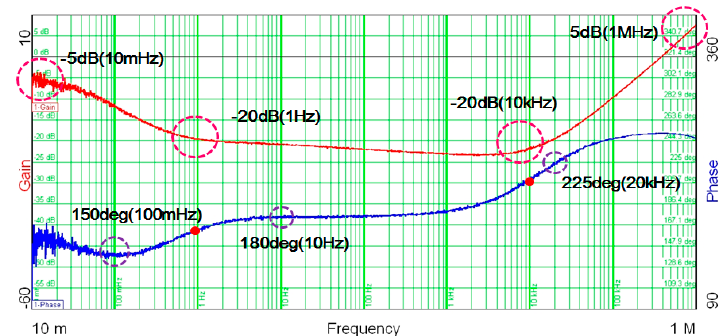
Figure 2 . Measurement results of the frequency response of the battery pack at the nominal voltage.